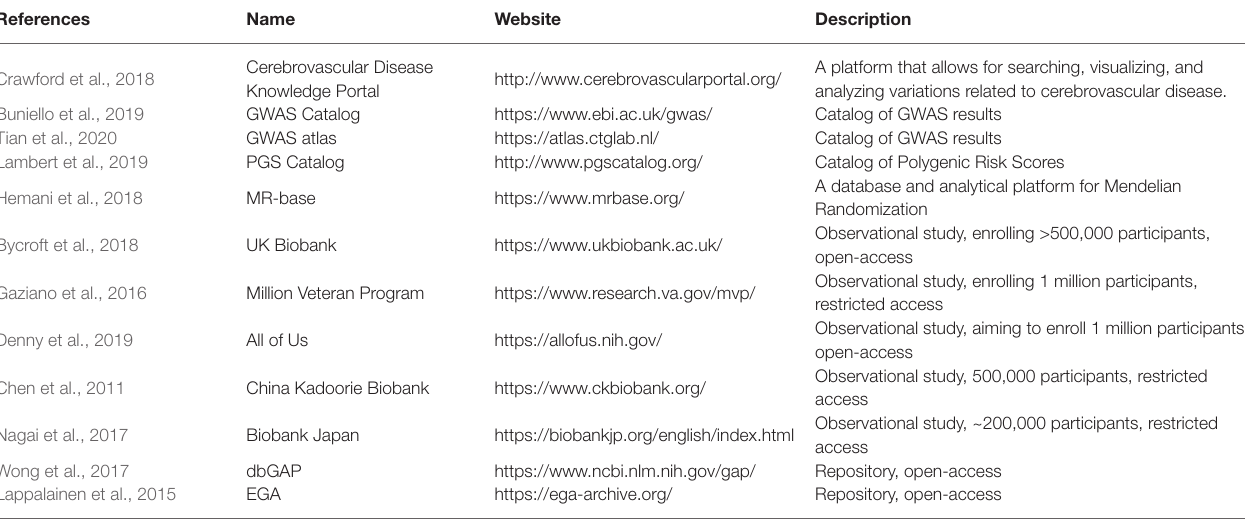
TABLE 1 | Online resources available for Mendelian Randomization